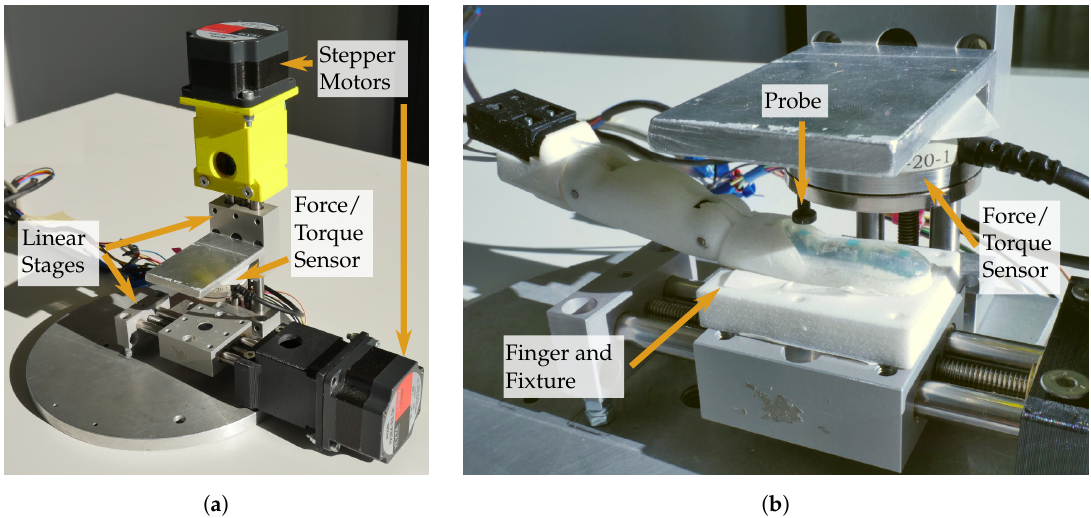
Figure 9. Linear table for normal force, shear force and spatial mapping experiments; ( a ) depicts an overview of the linear table; ( b ) shows a close up of the f/t sensor and finger attached to the